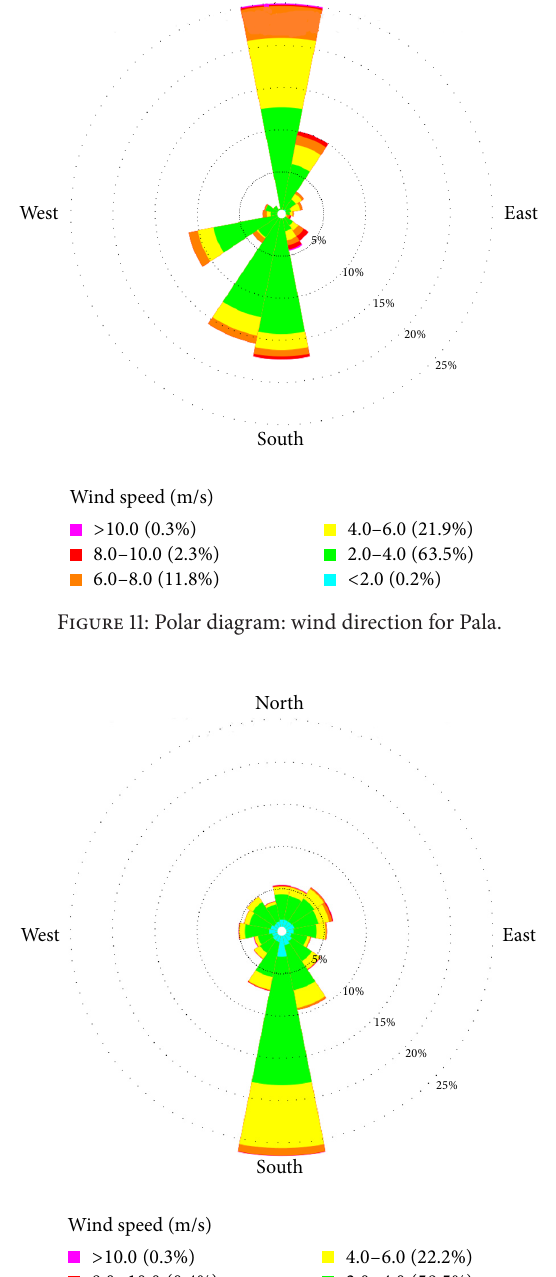
The seasonal variations of the mean wind speed data show that higher wind speeds are available when the weather condition is generally dry, that is, November to May, and lower wind speed is found when the weather condition is wet, that is, June to October. This trend is applicable for all the thirteen sites under investigation. Interestingly, it was learned that higher electrical energy demand in the country is also in this period (dry